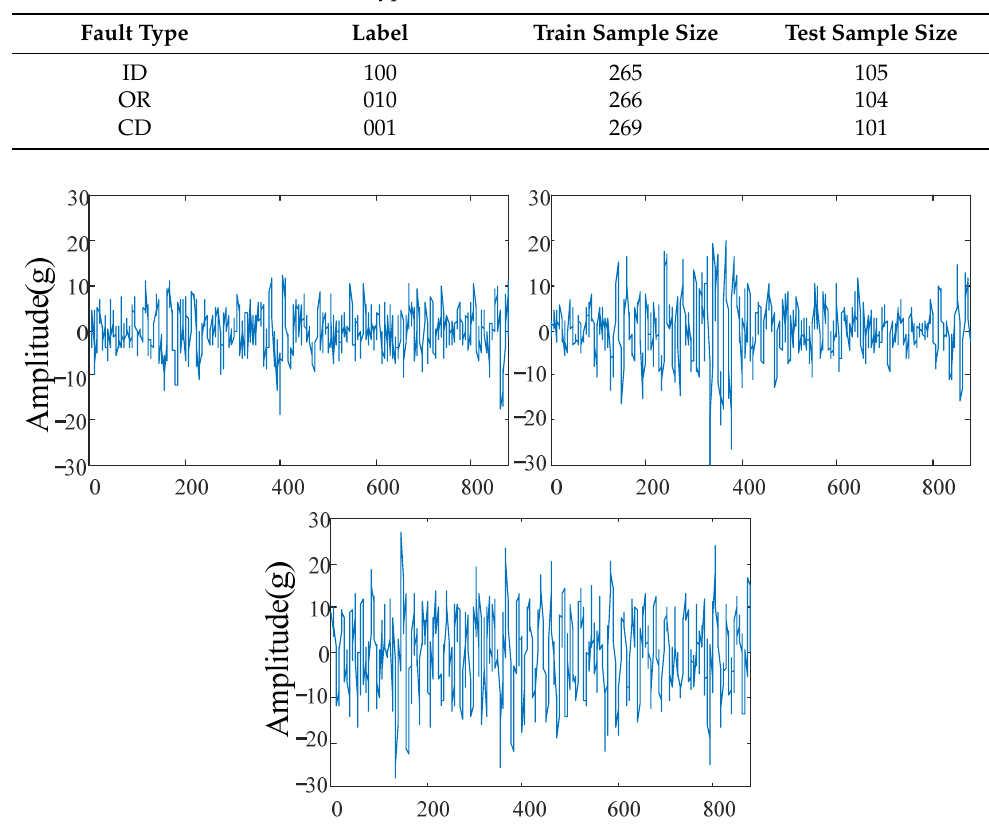
Table 11. Data information on three types of fault states.